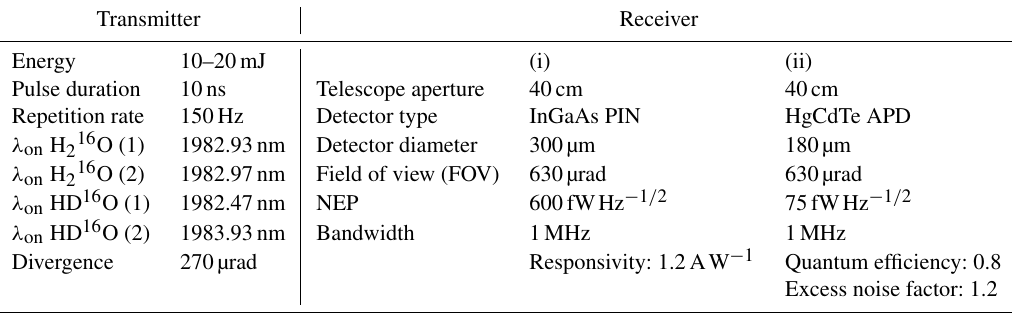
Table 2. DIAL instrument